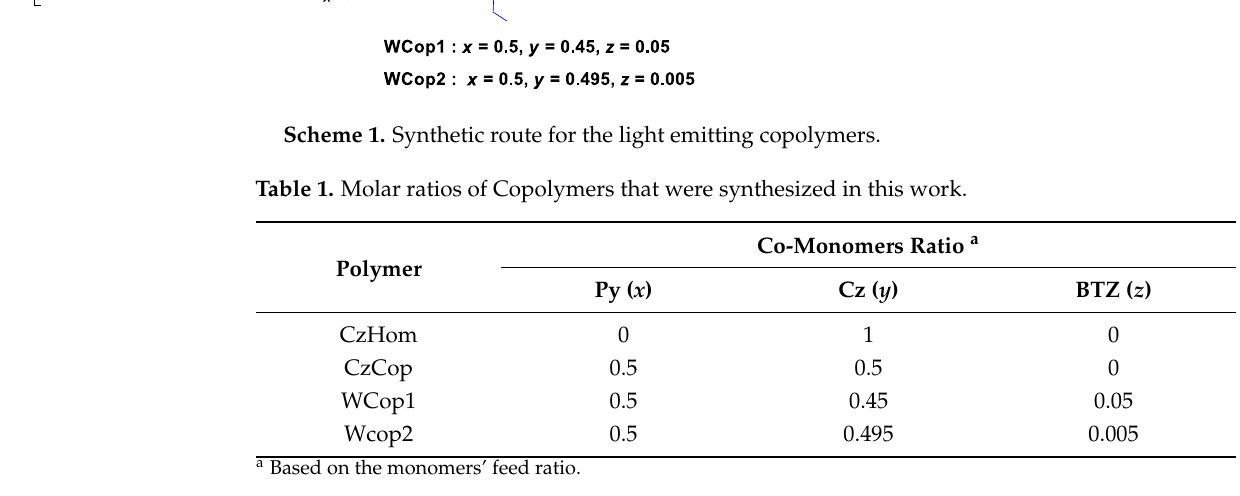
Table 2. Data obtained from Gel Permeation Chromatography (GPC) a of the synthesized polymers.